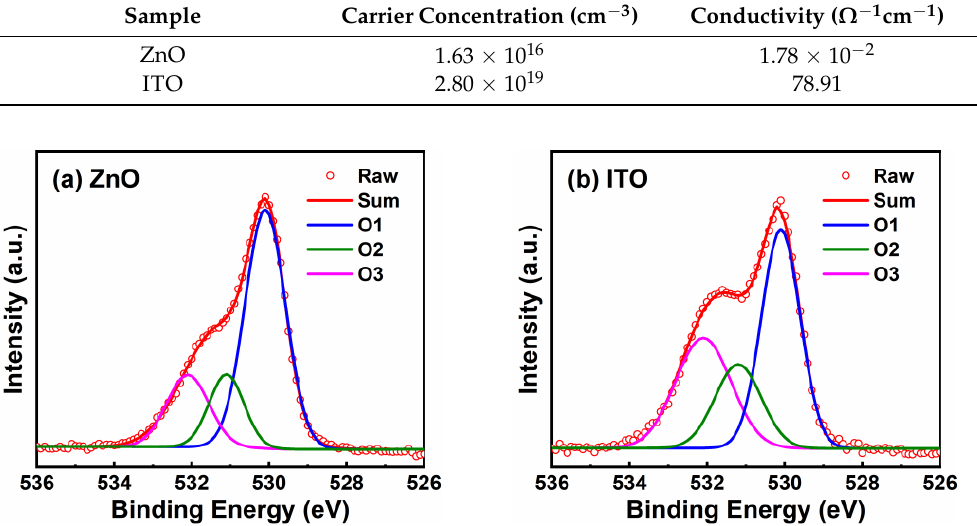
Table 1. Hall-effect results of ZnO and ITO films. ZnO and ITO films were deposited on glass substrates.